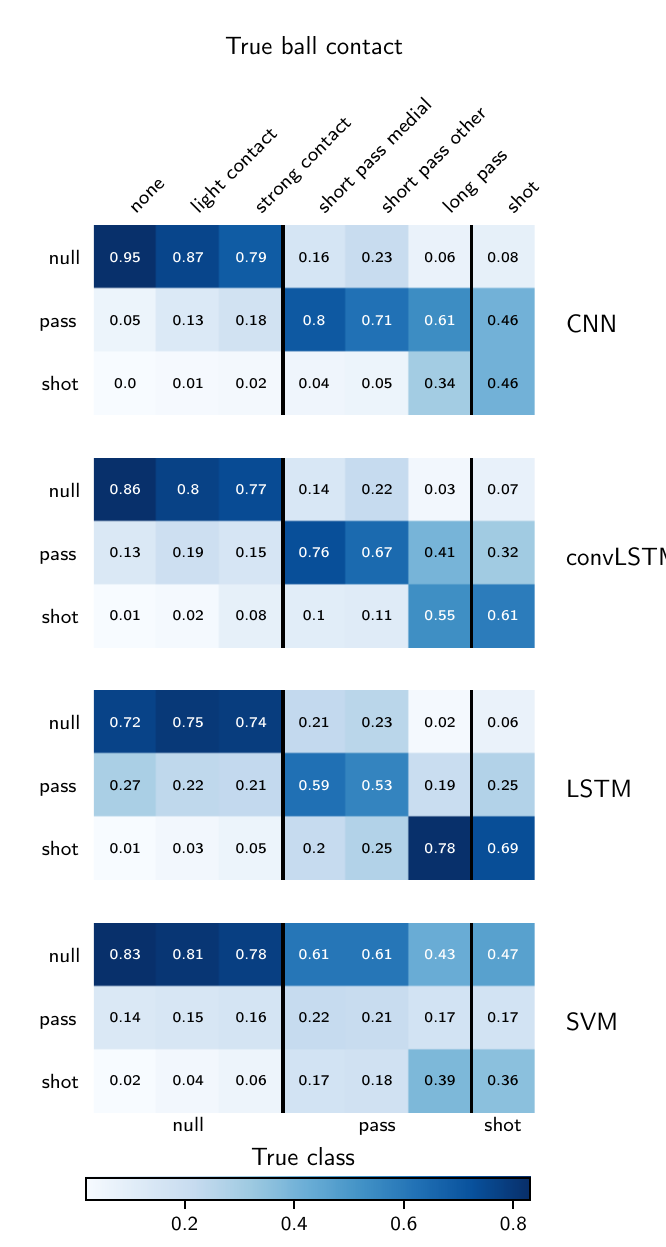
Figure 6. Classification performance of all models for the window_field evaluation using a moving window and candidate selection on laboratory data. A detailed explanation of the way of presentation can be found in Section 3.7. True and predicted classes are given on the bottom and left, respectively. Finer grained true ball contacts are shown on top. The given values are normalized over the true ball contact labels resulting in the greatest possible value being one and the smallest possible value being